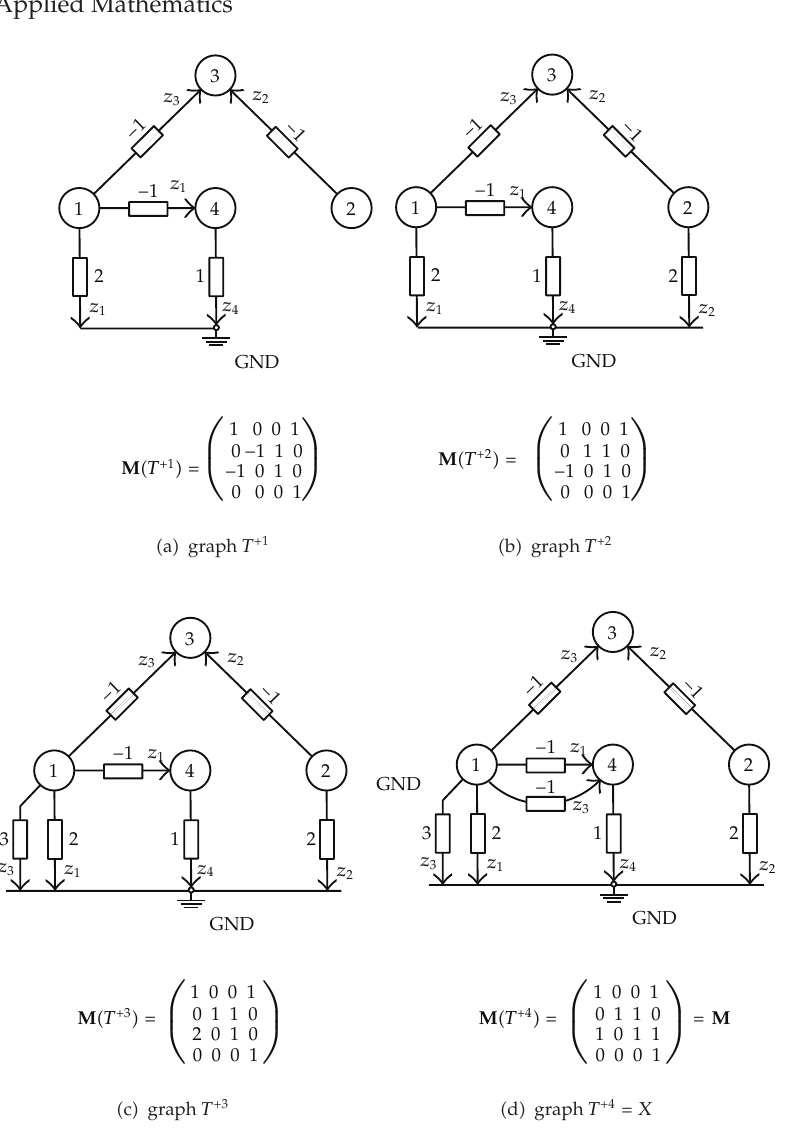
Figure 4: Four-node network